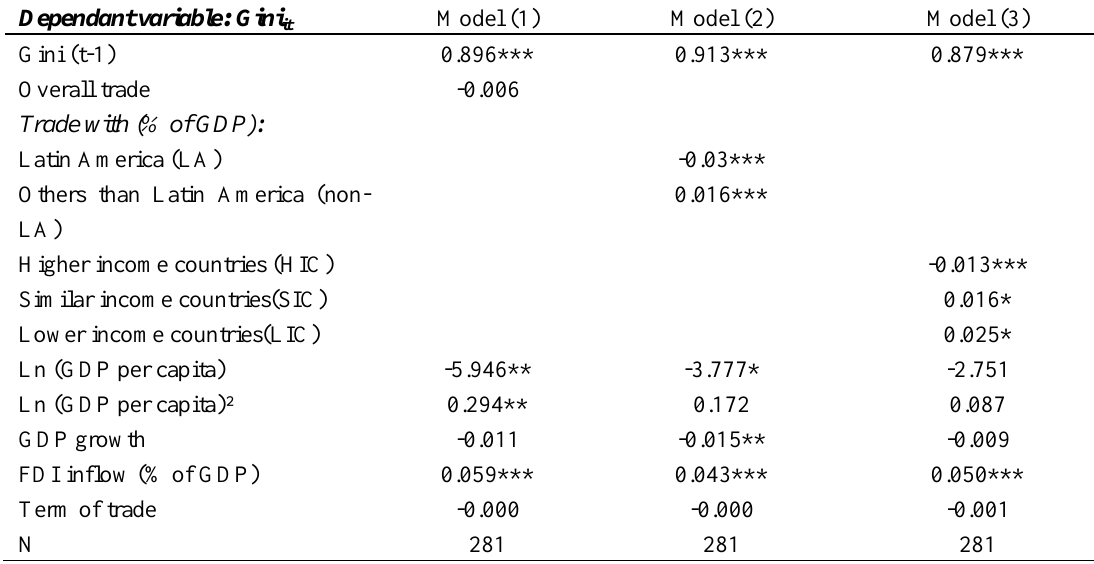
Table 1 : Effects of overall trade and trade by partners (% of GDP) on income